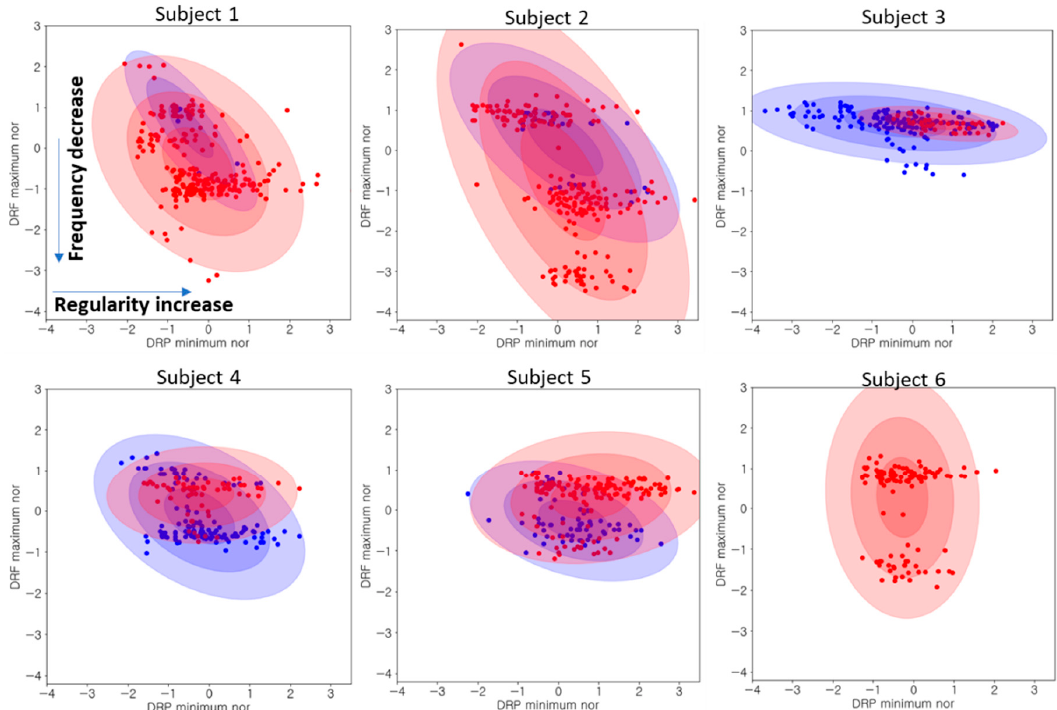
Figure 5. Scatterplots of existing features for each subject in our dataset. Here, blue dots represent wake epochs, and red dots represent drowsy epochs. The X-axis represents DRF% and the Y-axis DRF. The colored circles are the Gaussian distribution fitted for each label (i.e., drowsy or wake states).